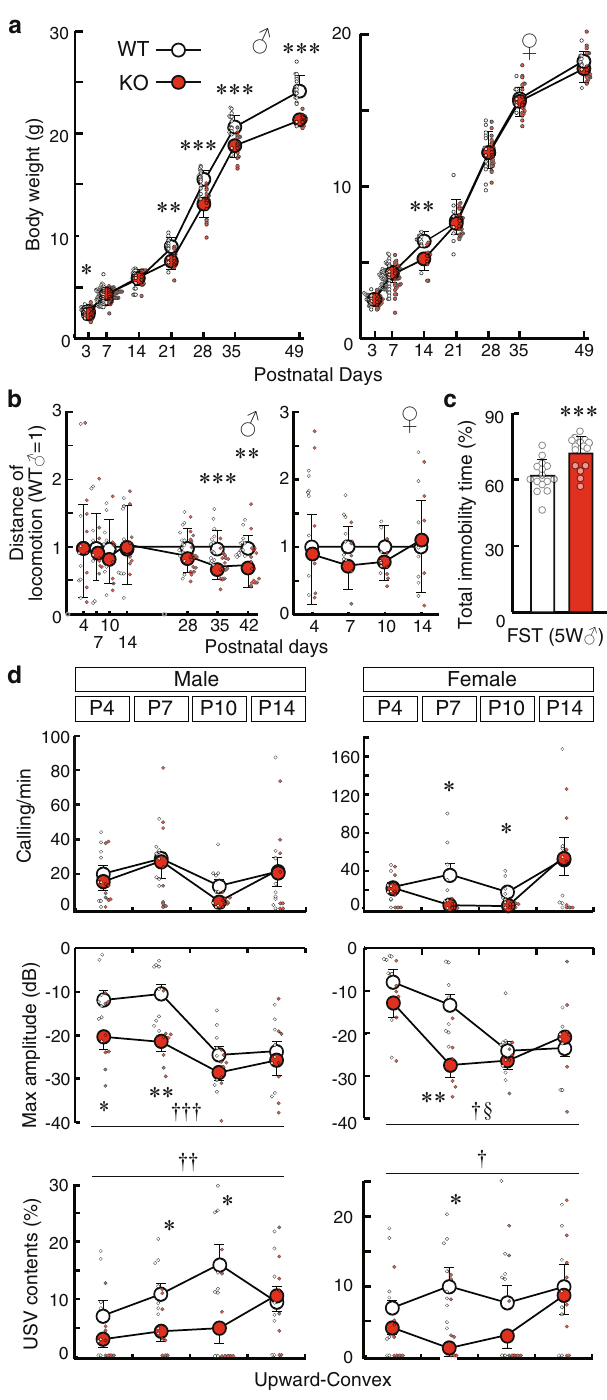
at P7 (male, P = 0.027; female, P = 0.013) and P10 (male, P = 0.026) (Fig. 1d and Supplementary Fig. 3).